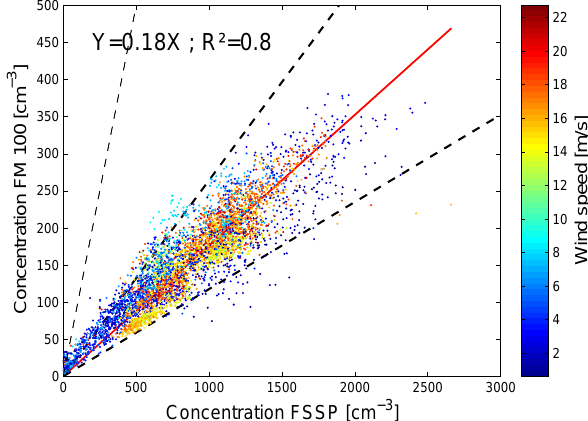
Figure 5. One minute averaged concentration in cm − 3 ; measure- ments were obtained from the FM-100 as a function of the FSSP concentration of the FSSP. The colors show the values of the wind speed. The bold dashed lines show the instrumental errors applied to the fit. The 99% confidence interval of the slope value was esti- mated to be [0.177, 0.183].